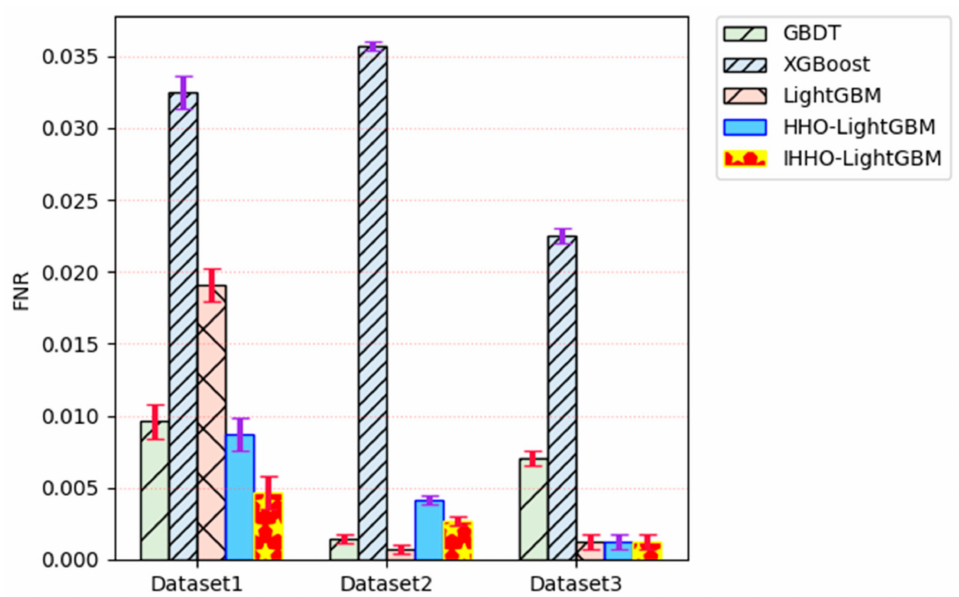
Figure 7. FNR of four algorithms for fault